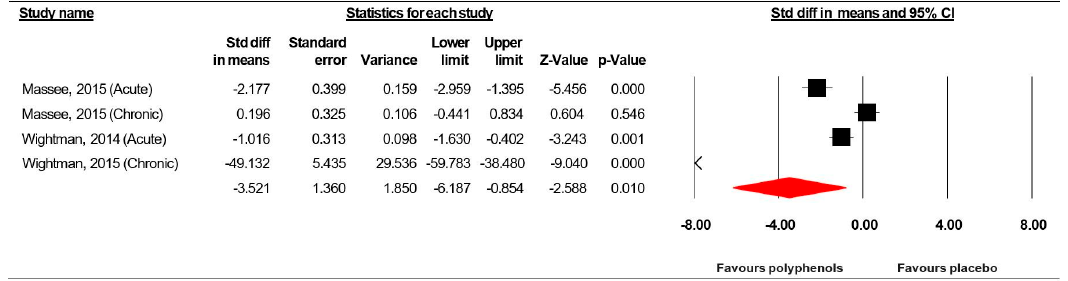
Figure 6. Forest plot of studies investigating the effect of (poly) phenol-rich supplementation on mental fatigue (MF).